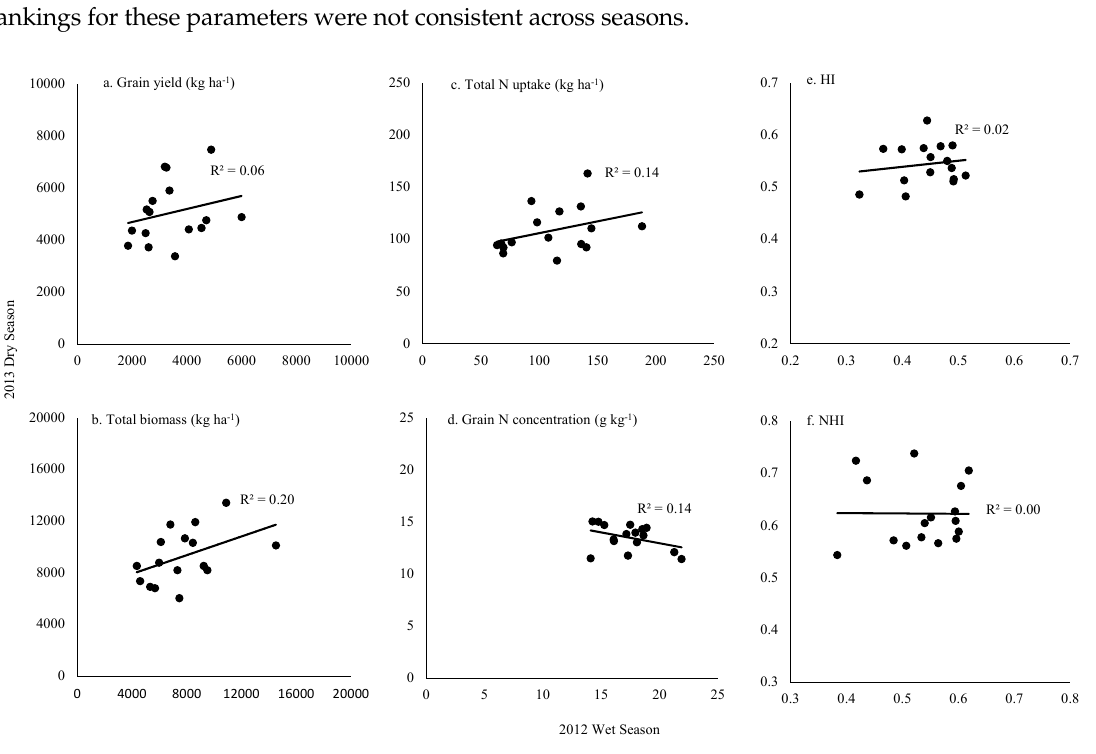
Figure 1. Correlations between key yield and nitrogen parameters Grain yield ( a ), total N uptake ( b ), HI ( c ), Total biomass ( d ), Grain N concentration ( e ) and NHI ( f ) across the 2012 wet season and the 2013 dry season.